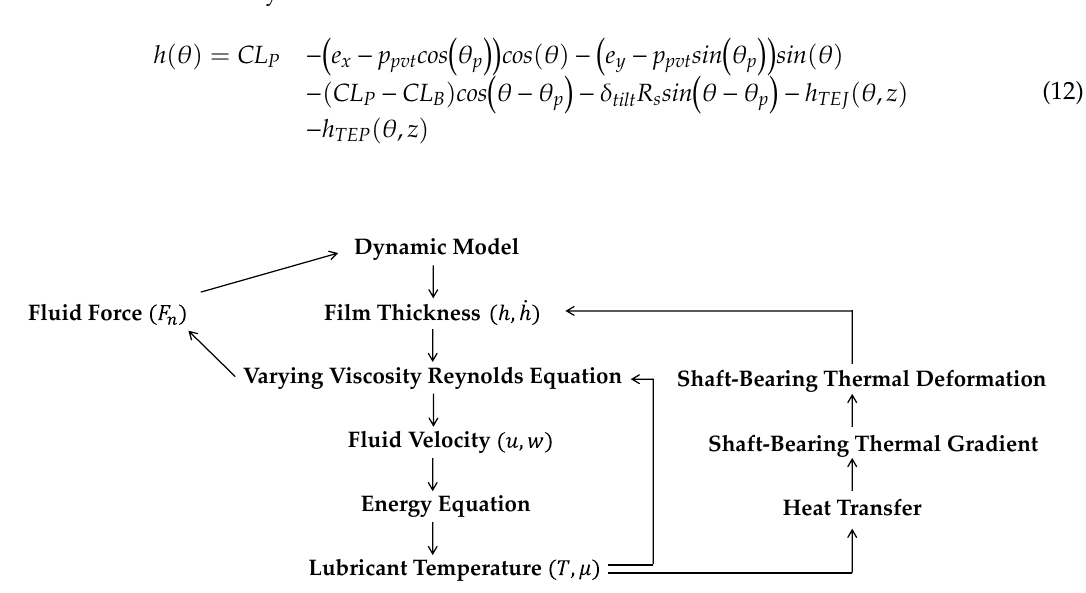
Figure 3. Thermo-hydrodynamic lubrication model.